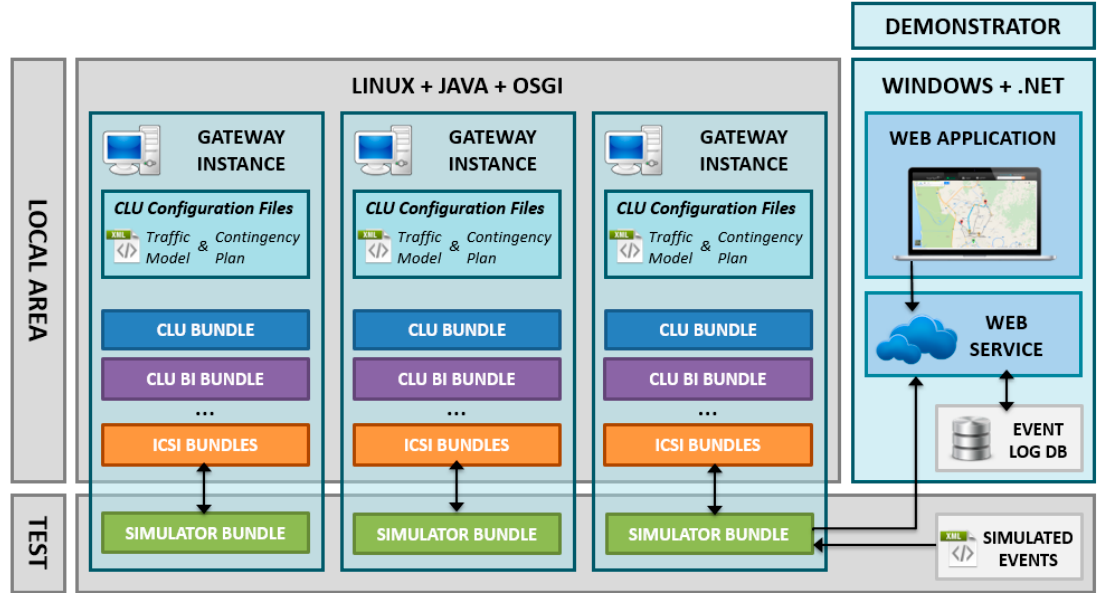
Figure 5. Architecture Test Environment.